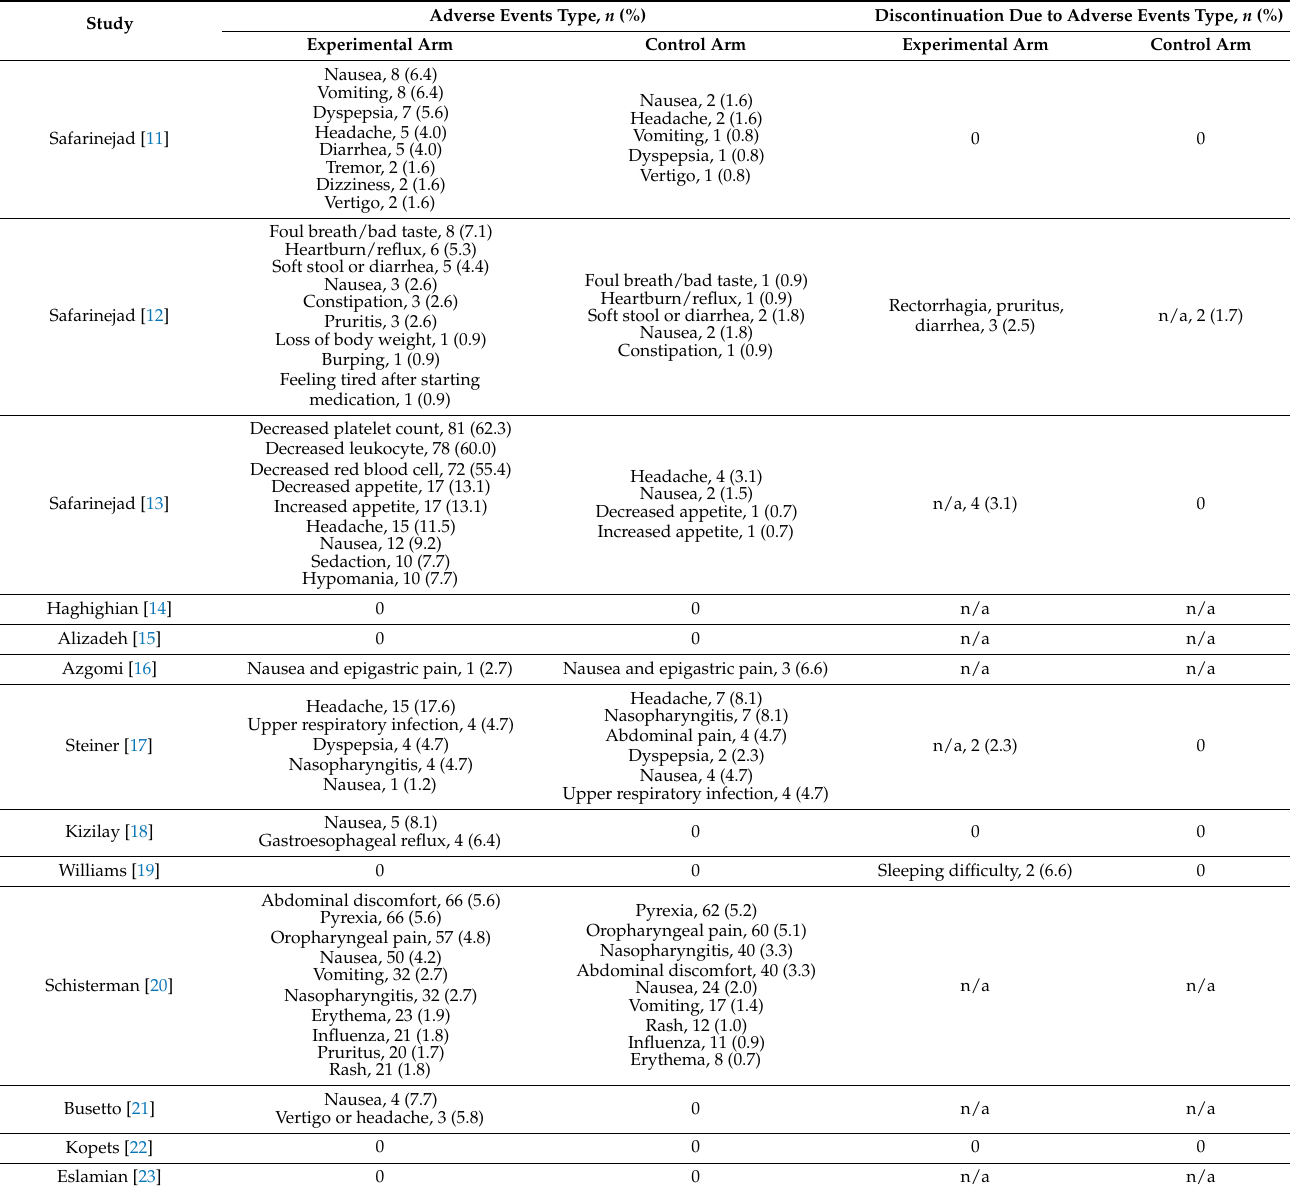
Table 2. Adverse events reported by the included studies in the experimental and control